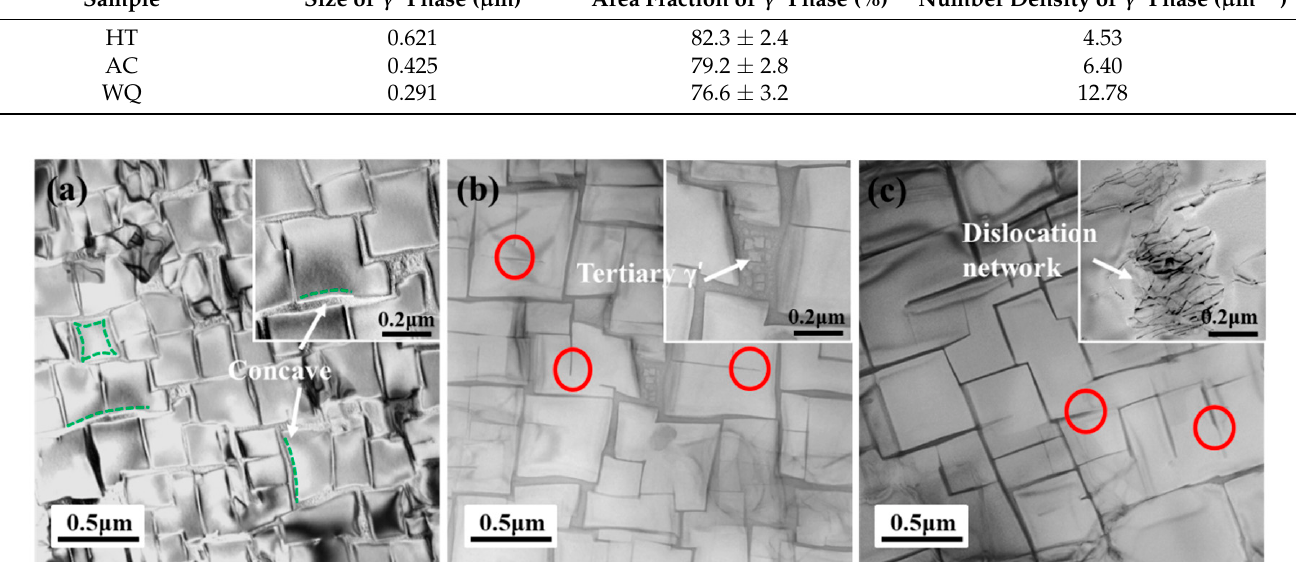
Table 4. The compositions of γ - and γ′ phase under different cooling conditions and fully heat treat- ment (at.%).